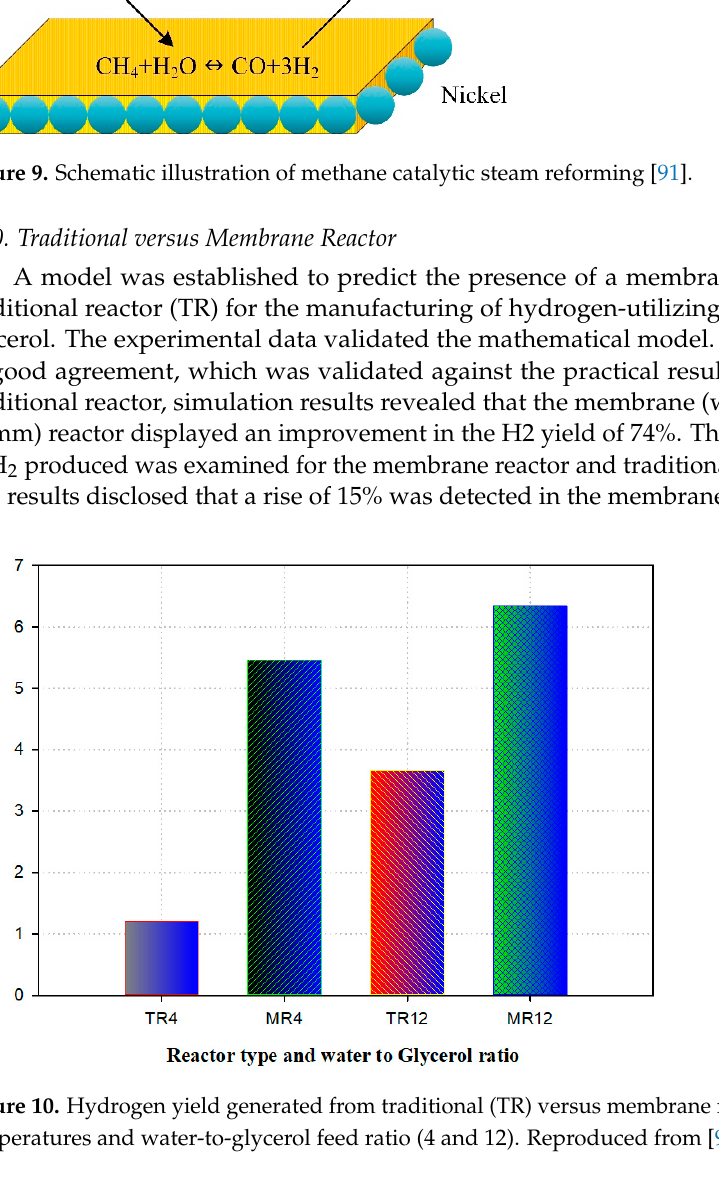
Figure 8. Schematic diagram of thermally double-coupled reactor [90].